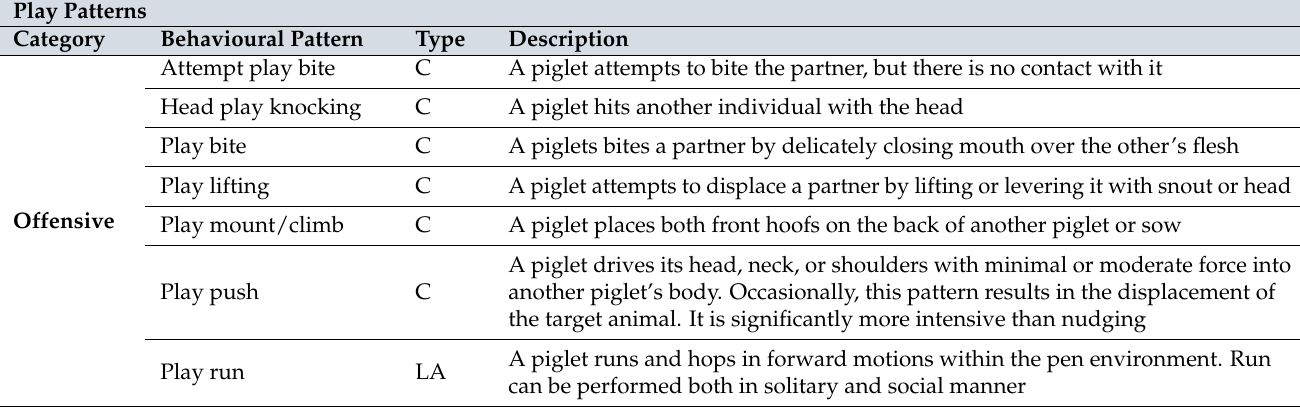
Table 2. Ethogram with play patterns recorded in the current study.